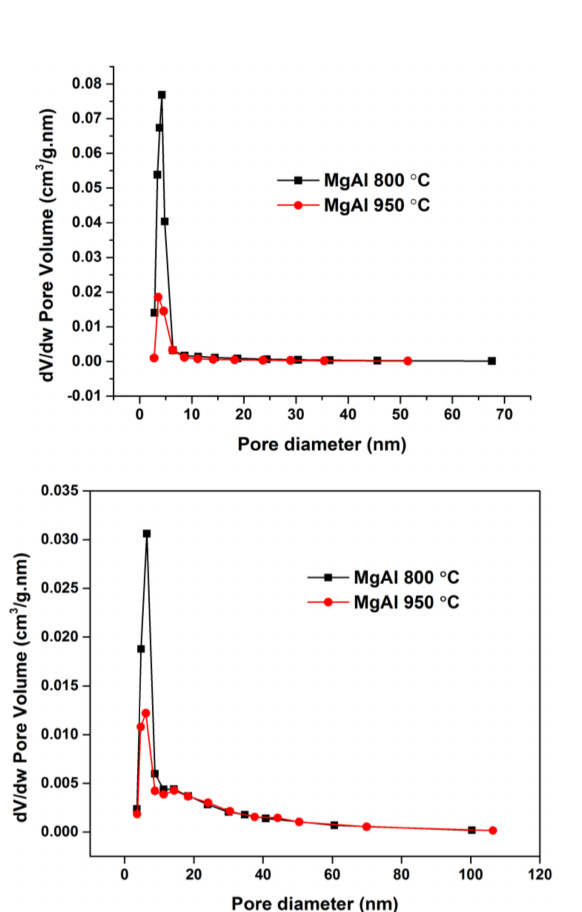
Figure 14. The pore size distribution of mixed metal oxides (MMO) obtained by heating the Mg 2 / Al 1 precursor gels ( top ) and obtained by heating the Mg 2 / Al 1 LDHs ( bottom ) at 800 ◦ C and 950 ◦